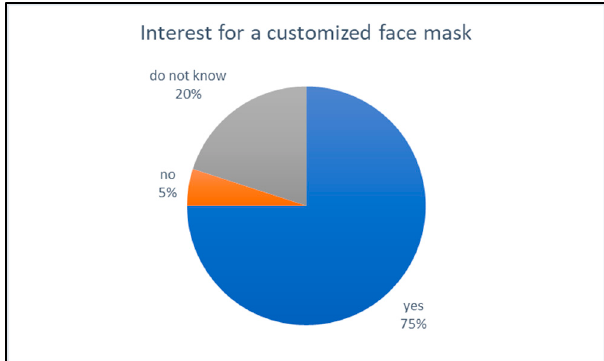
Figure 7. Interest for a customized device. Section 4 evaluated the Mask Fitter.